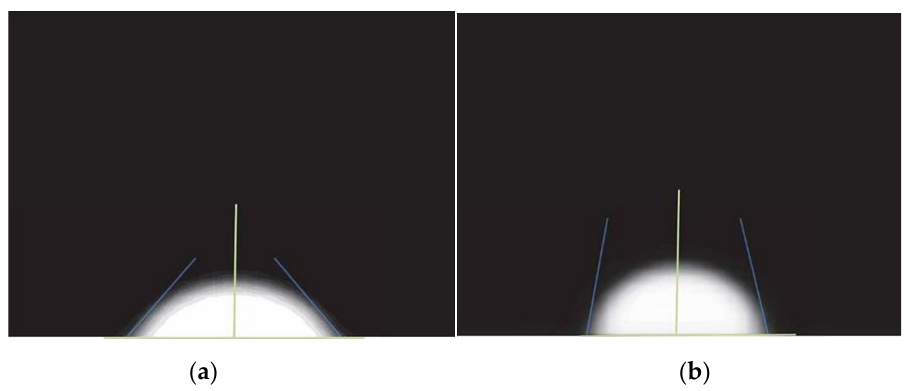
Figure 4. Contact angle for core 3 before ( a ) and after ( b ) exposure to the foaming agent solution